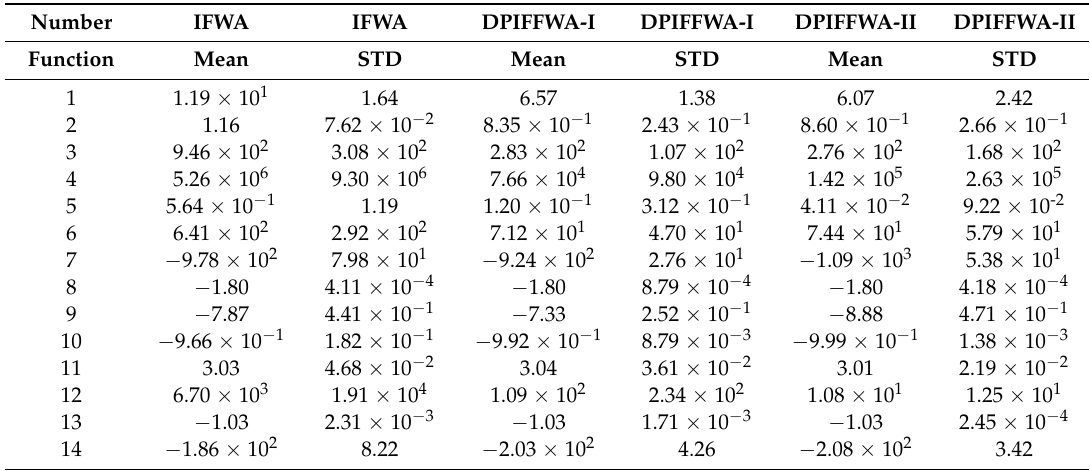
Table 10. Mean and standard deviation of the fourteen benchmark functions with SI = 3.